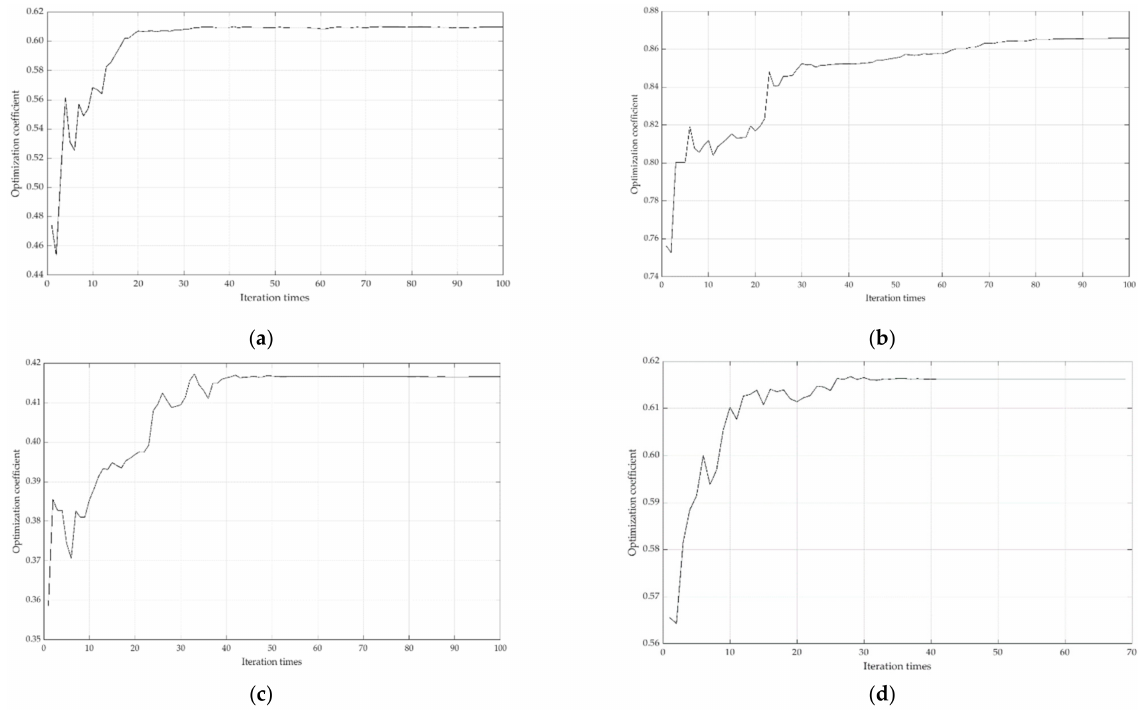
Figure 9. Iteration trend of RAGA-PPM of local emergency resilience in each dimension: ( a ) iteration trend of RAGA-PPM of resistance capacity; ( b ) iteration trend of RAGA-PPM of restore capacity; ( c ) iteration trend of RAGA-PPM of dynamic adaptability; ( d ) iteration trend of RAGA-PPM of collaborative